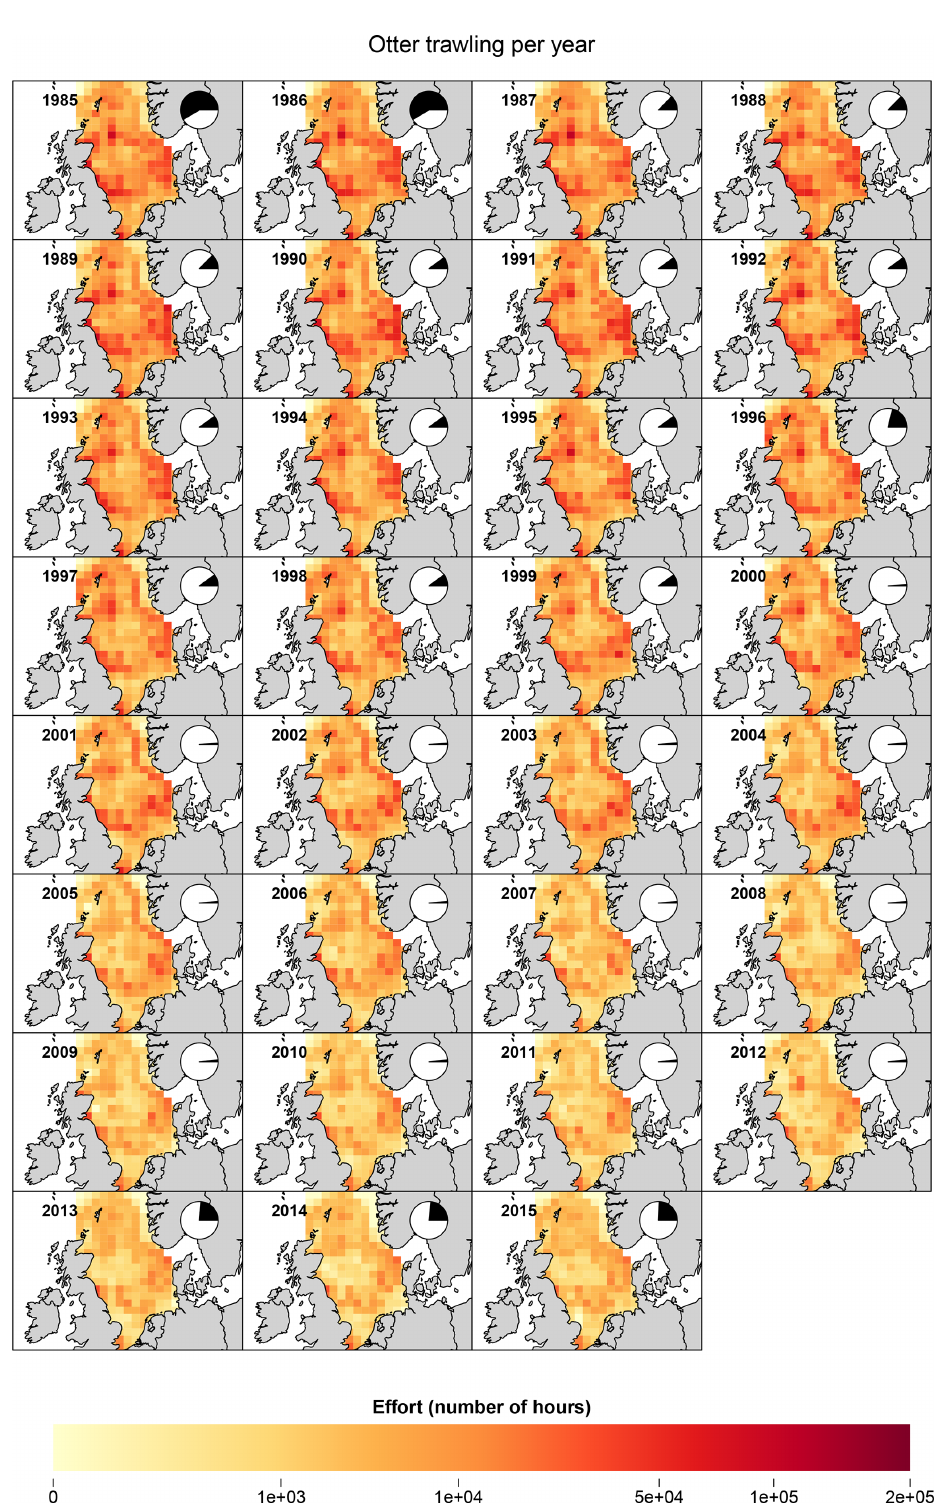
Figure 4. Spatial distribution of otter trawling effort (number of hours trawling per ICES rectangle) in the North Sea in 1985–2015. Pie charts in the top right corners of each plot show the proportions of reconstructed trawling effort sourced from compiled (nominal) data (white) and estimated data